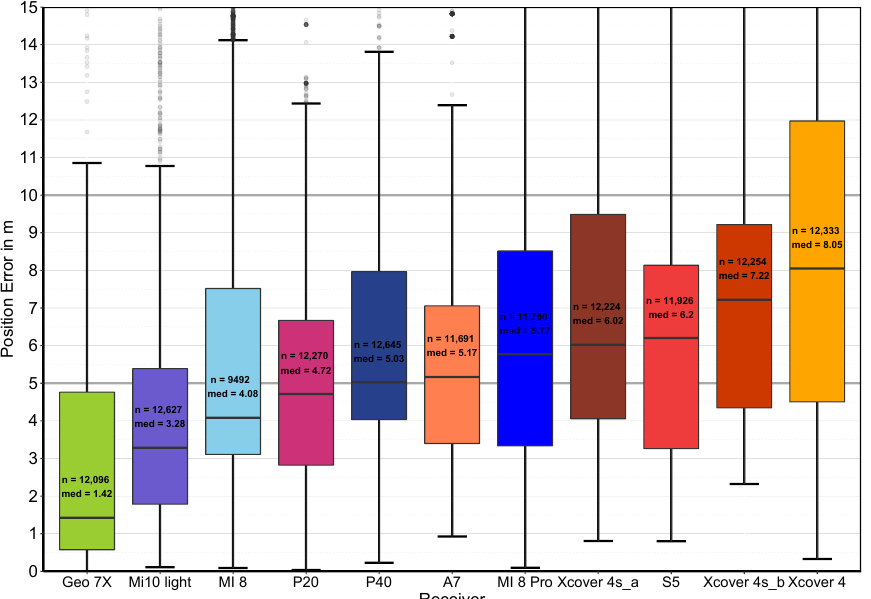
Figure 10. Boxplot of the absolute position error of the different receivers. Blue indicates smartphones that have multi-frequency capabilities, and red indicates smartphones that can only receive the L1/G1/E1/B1l bands.